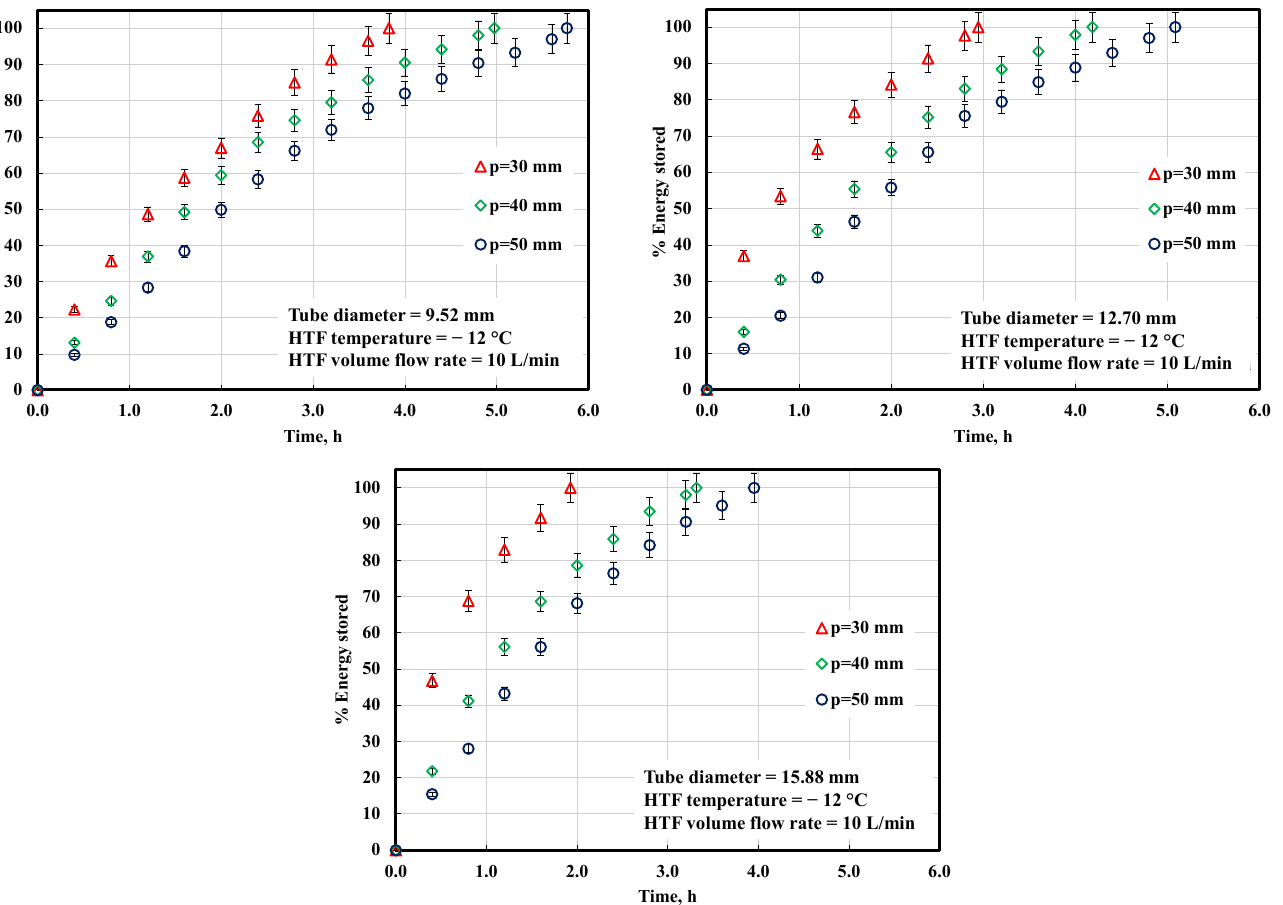
Figure 3. Percentage of energy stored with time for different coil pitches with coil tube diameters during the charging process.